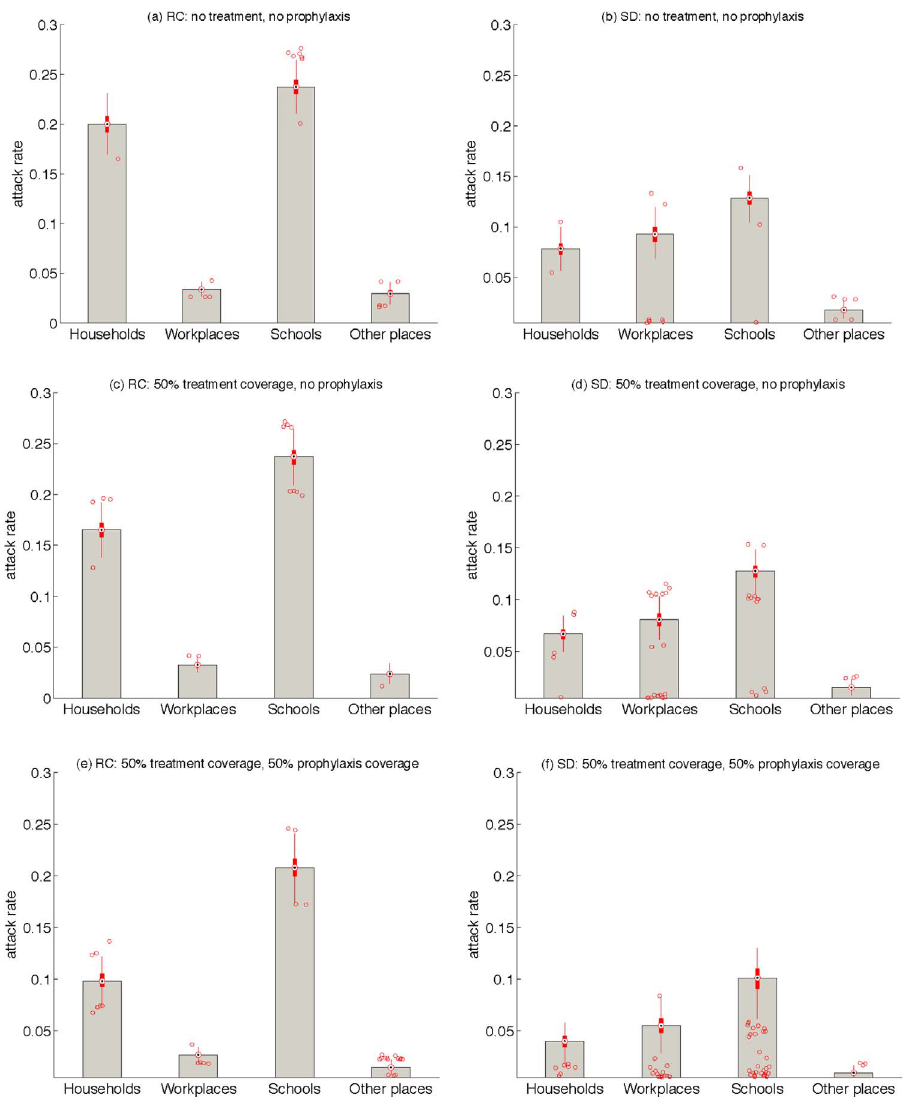
Figure 6. The projected effective use of antiviral drugs when combining antiviral treatment of infectious cases (y-axis) with prophylaxis of close contacts (x-axis) in the remote community model (RC) (a–c) and the shifted demographics model (SD) (d–f). Antiviral treatment delays range from 1 day to 3 days post symptom onset. Contours describe the amount of antiviral wastage (counted in the number of courses given) for dispensing drugs as prophylaxis.